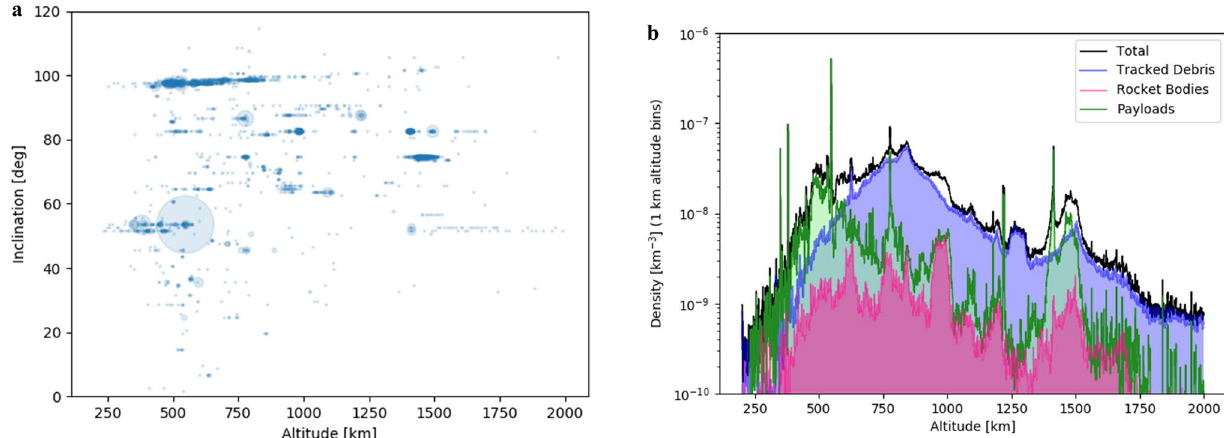
Figure 2. Orbital distribution and density information for objects in Low Earth Orbit (LEO). (Left) Distribution of payloads (active and defunct satellites), binned to the nearest 1 km in altitude and 1° in orbital inclination. The centre of each circle represents the position on the diagram, and the size of the circle is proportional to the number of satellites within the given parameter space. (Right) Number density of different space resident objects (SROs) based on 1 km radial bins, averaged over the entire sky. Because SRO objects are on elliptical orbits, the contribution of a given object to an orbital shell is weighted by the time that object spends in the shell. Despite significant parameter space, satellites are clustered in their orbits due to mission requirements. The emerging Starlink cluster at 550 km and 55° inclination is already evident in both plots (Left and